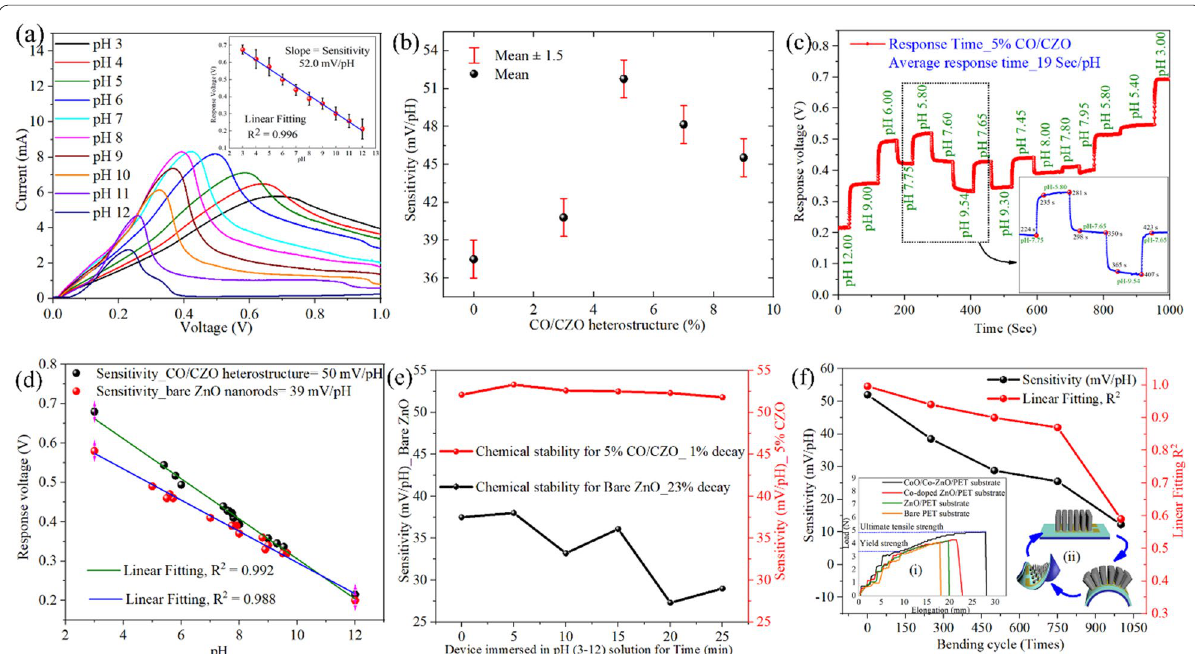
Fig. 5 a I–V curves for pH sensing performances and (inset in a ) variation in response voltage of the 5% CO/CZO heterostructure–based electrode. b Variation in sensitivity of bare ZnO nanorods and the 3%, 5%, 7%, and 9% CO/CZO heterostructure. c Variation in response time of the 5% CO/ CZO heterostructure–based device and its corresponding sensitivity determined by the d calibration plot. e Variation in sensitivity of the bare ZnO-based device and the 5% CO/CZO heterostructure–based device after immersion for 25 min in solutions of different pH values to demonstrate their chemical stability. f Variation in sensitivity and linearity of the 5% CO/CZO heterostructure–based device, when it was deformed mechanically as a sketch in inset-(ii), while inset (i) shows stress–strain plot of bare PET, ZnO/PET, Co-doped ZnO/PET, and CO/CZO heterostructure/PET-based